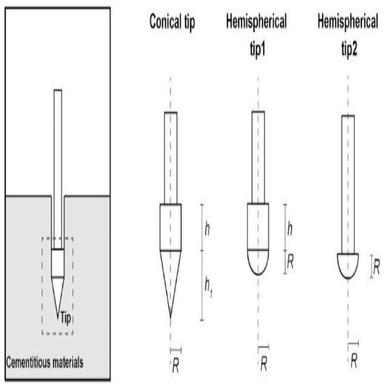
Schematic illustration of different penetrometer tips, modified from Ref..